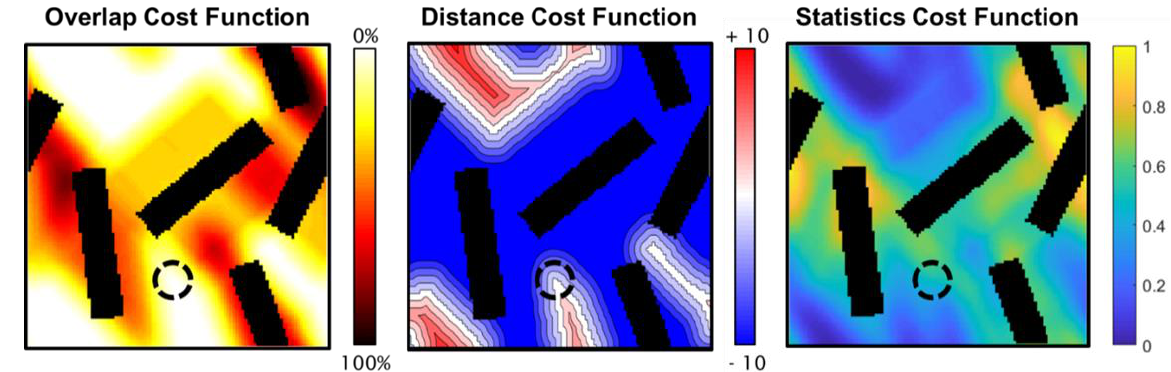
Figure 10. Computed cost functions for the generation example in this study.